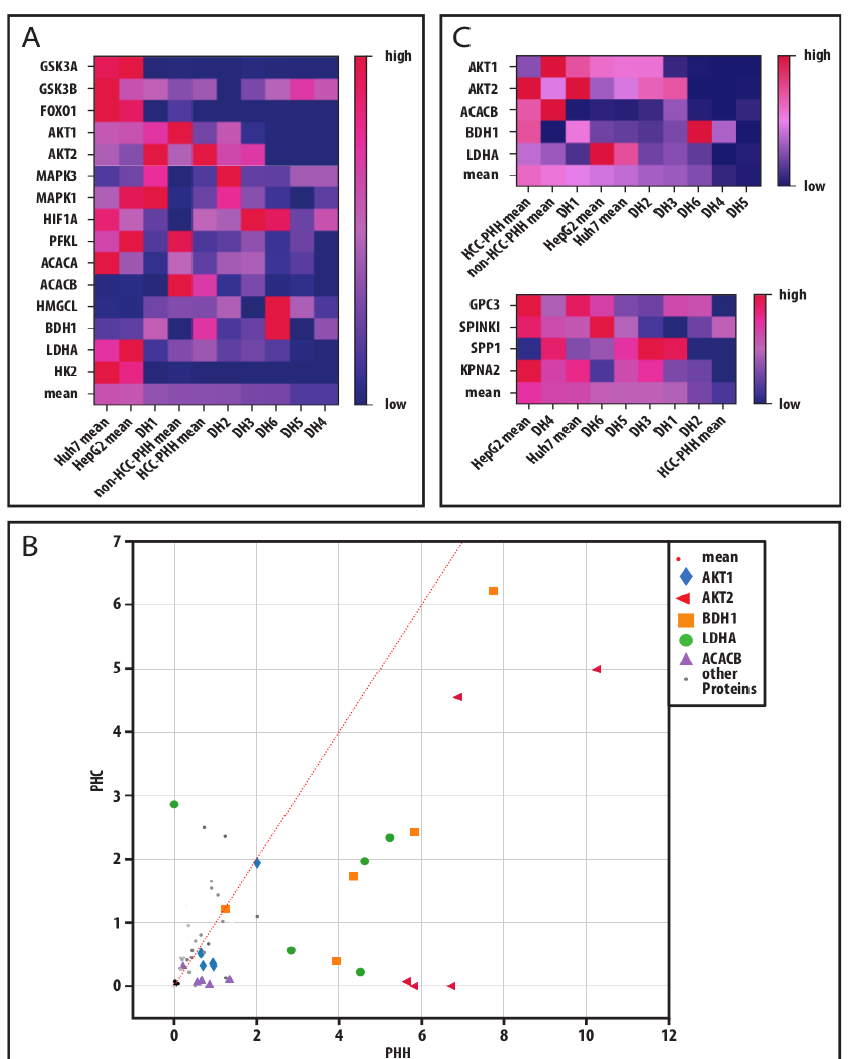
Figure 6. Metabolic and cancerous dedifferentiation of primary human hepatoma cells. ( A ) Absolute protein values of measured markers were transferred to a relative percentage scale. The relative values were displayed in their respective color on a color gradient. Mean values of a donor or cell entity were calculated from all markers in a column and the columns were sorted by their respective relative mean values resulting in heat maps. This analysis was performed for all investigated metabolic protein markers to display their metabolic dedifferentiation. ( B ) Absolute protein values of metabolic markers measured in PHCs, and their corresponding PHHs were also plotted to display their metabolic shift through cancerous dedifferentiation and key players were identified by their distance to the identity function (slope = 1). ( C ) For investigation of a link between metabolic and cancerous dedifferentiation in PHCs derived from different donors compared to hepatoma cell lines and PHHs, the heat maps of the selected metabolic key players and of hepatocellular tumor markers are displayed. Abbreviations: PHH, primary human hepatocyte; HCC, hepatocellular carcinoma; DH, HCC-diagnosed patient